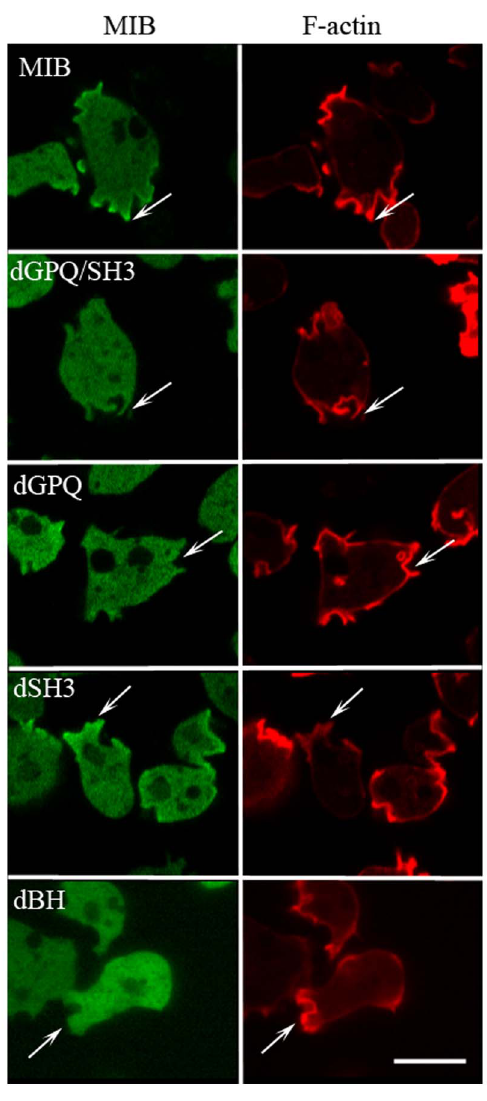
Figure 13. The GPQ-region is required for localization of MIB to protrusions on the dorsal cell membrane. myoB 2 -cells co- transfected with mRFP-lifeact and either GFP-MIB or GFP-tagged MIB mutants, as indicated in the figure, were starved for 2 h and monitored for the presence of MIB and its mutants in the actin-rich protrusions on the dorsal cell membrane. These images were taken at a higher focal plane than images visualizing actin waves on the ventral surface. Arrows point to actin-rich protrusions. Bar is 10 m m.